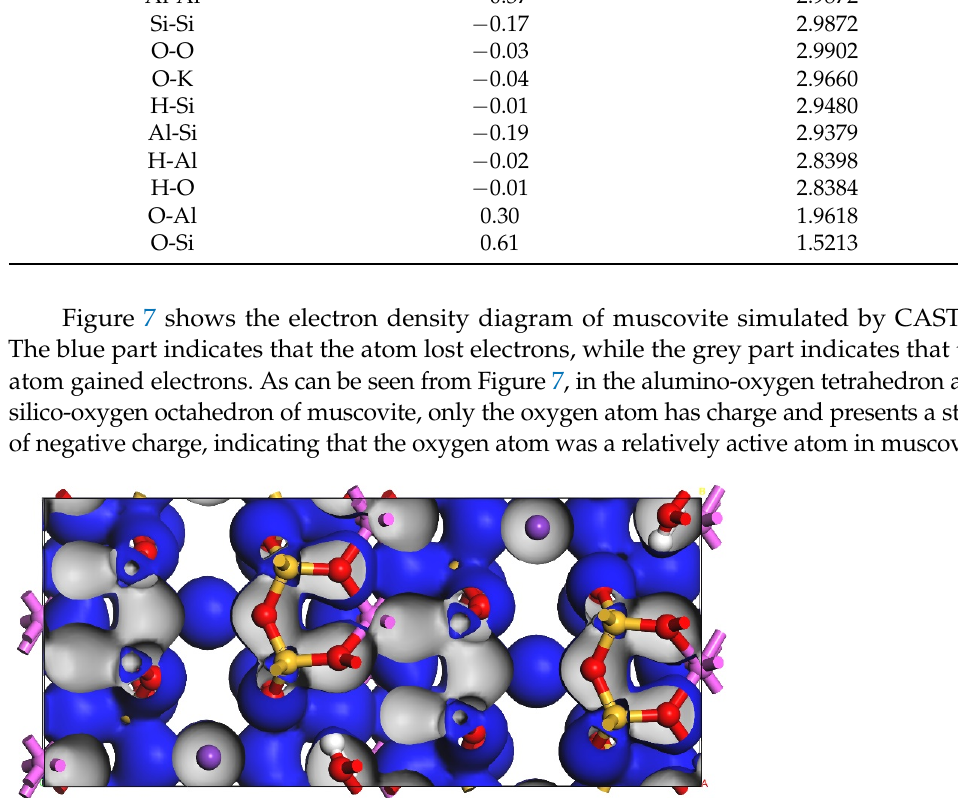
Figure 7. Electron density of muscovite (the color of yellow, pink, red, purple, and white represents silicon, aluminum, oxygen, potassium, and hydrogen atoms,